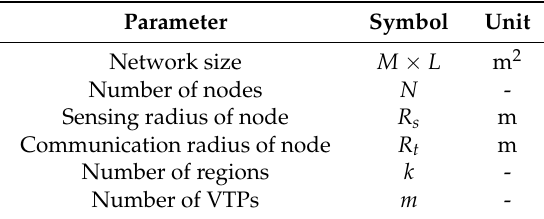
Table 1. Definitions of parameters about the network.